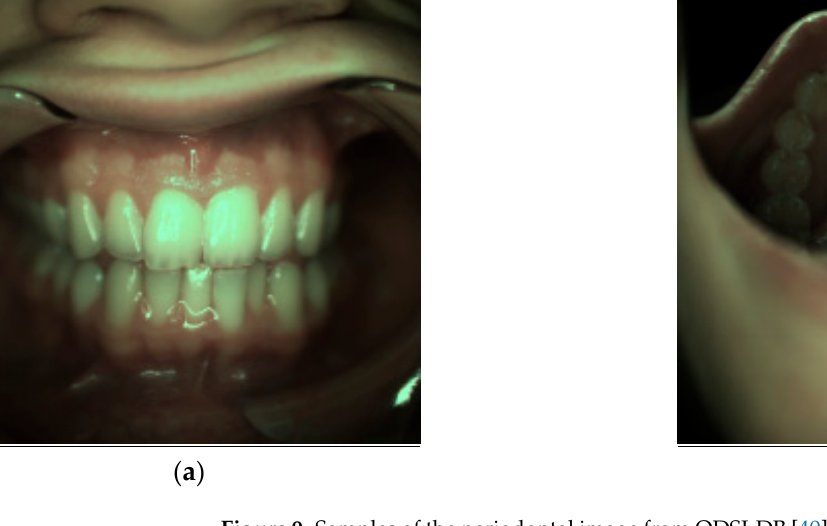
Table 4. Samples chosen for the one-vs-rest